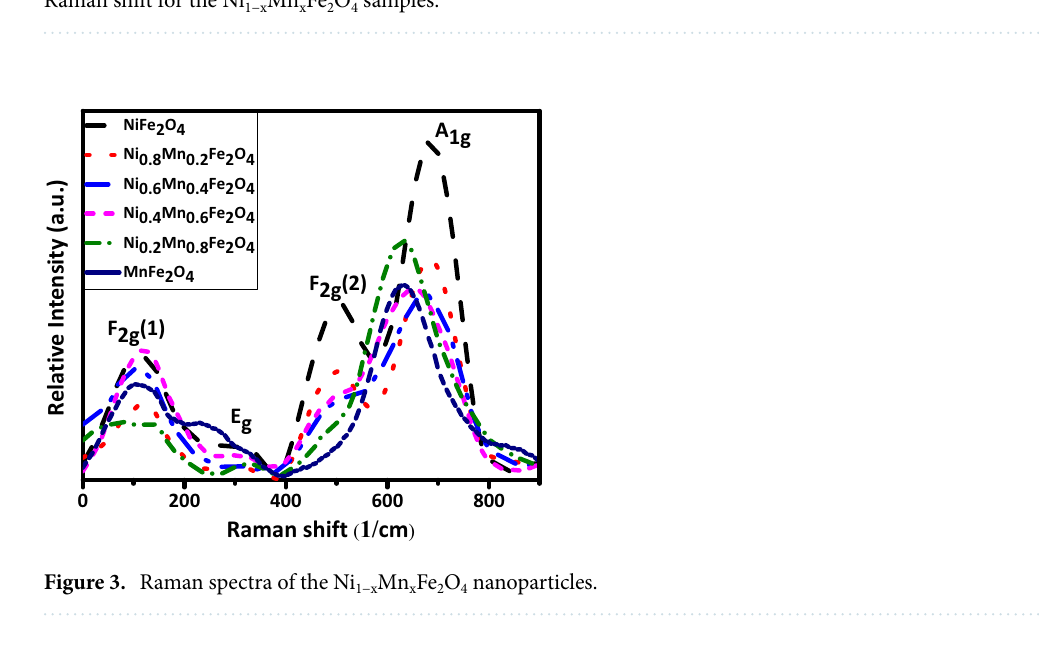
where d hkl is the inter-planar spacing for the most intense peak (311). It is seen that the lattice parameter a increases as the content of Mn +2 ions increases, which could be attributed to the larger ionic radius of Mn +2 (0.8 Å) than Ni +2 (0.69 Å). It is also seen that MnFe 2 O 4 has both a larger crystallite size and a higher compressive strain than NiFe 2 O 4 , which is because of the stronger bonds that Mn +2 ions can form, as confirmed by Raman spectra (Fig. 3). Raman spectra of the Ni 1−x Mn x Fe 2 O 4 nanoparticles are shown in Fig. 3. The A 1g band is due to the symmetric stretching of oxygen atoms along Fe–O (or M–O) tetrahedral bonds, the F 2g (1) band is due to the translatory movement of the whole tetrahedron (FeO 4 ), the F 2g (2) band is due to the asymmetric stretching of Fe/M–O bonds, and the E g band is due to the asymmetric and symmetric bending of O with respect to Fe 42 . The inverse spinel structure of the samples is confirmed by the Raman analysis 43 . As it is seen in Fig. 3 and Table 2, the A 1g peak shifts toward a lower frequency (from 687 to 630 1/cm) and the intensity of the F 2g (2) peak decreases as Ni +2 ions are substituted with Mn +2 ions, consistent with differences between the Raman spectra of inverse and normal spinel structures 44 . This is due to the smaller ionic radius of Ni +2 than Mn +2 . As a result, when Ni +2 ions are substituted with Mn +2 ions the lengths of bonds between the cations with the host atoms increase, leading to stronger interactions between atoms 45,46 . The experimentally obtained Raman modes are consistent with those for Ni 0.75 Zn 0.25 Fe 2 O 442 , Mn x Fe 3−x O 447 , and ZnCuFe 2 O 448 . Figure 4 shows the optical absorption spectra of the prepared Ni 1−x Mn x Fe 2 O 4 nanoparticles. It is seen that as the content of Mn +2 increases the absorption edge undergoes a redshift and the absorbance is enhanced in both visible and near-infrared regions. These absorption spectra are consistent with those of previous reports on crystalline Mn